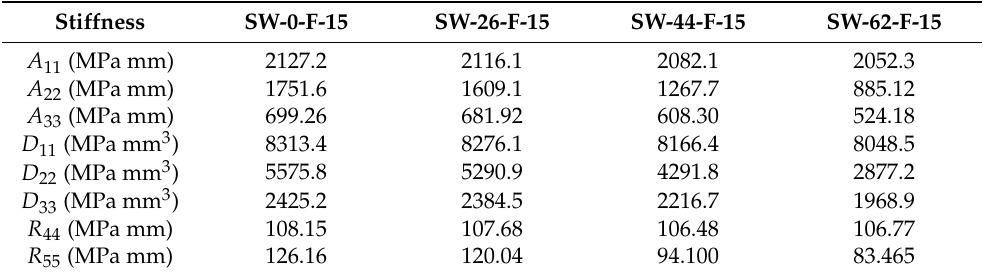
Table 8. The selected stiffnesses in SW models for different perforations and flute rotated by 15 degrees.